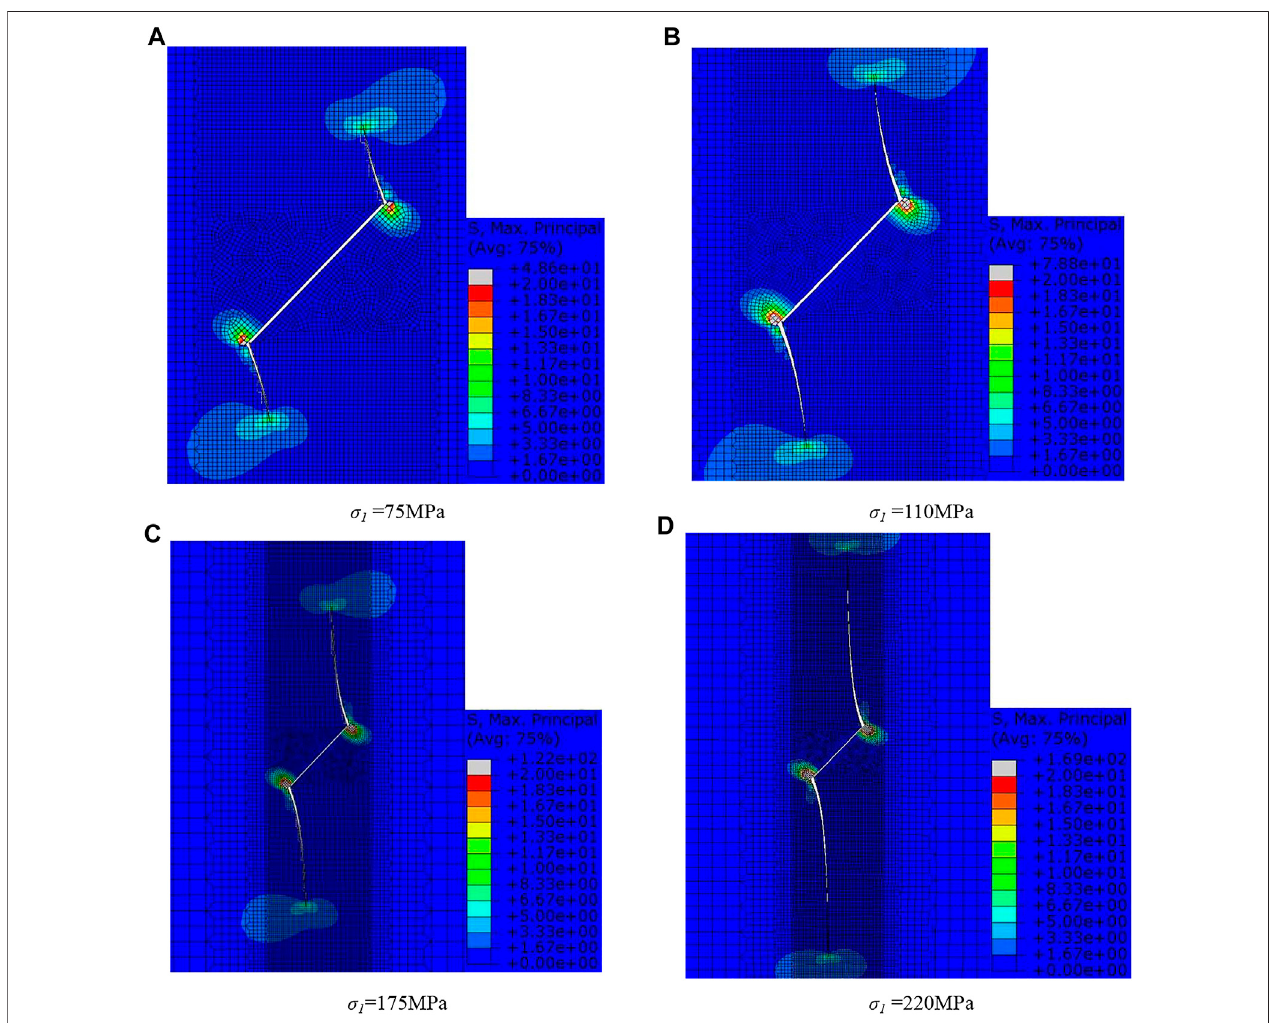
FIGURE 7 | Maximum principal stress and crack propagation of the XFEM model. (A) σ 1 = 75 MPa, (B) σ 1 = 110 MPa, (C) σ 1 = 175 MPa, and (D) σ 1 = 220 MPa.